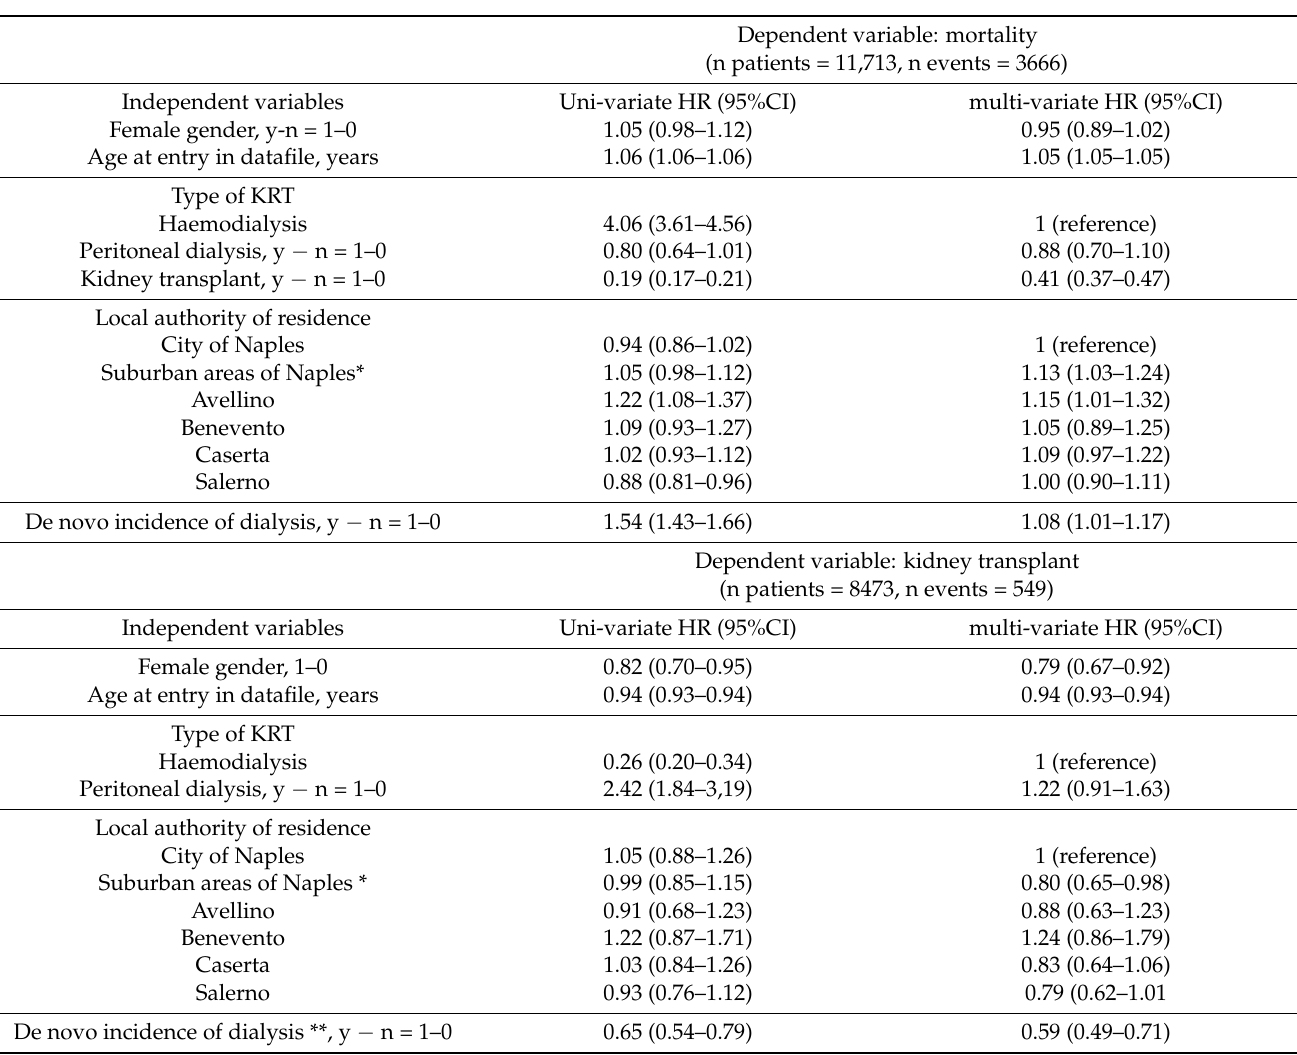
Table 2. Cox regression analyses on mortality and access to kidney transplant (dependent variables) among residents in the Campania region on kidney replacement treatment from 2015 to 2018: uni- and multivariate HR (95%CI), bold character for HR significantly (cid:54) = 1.